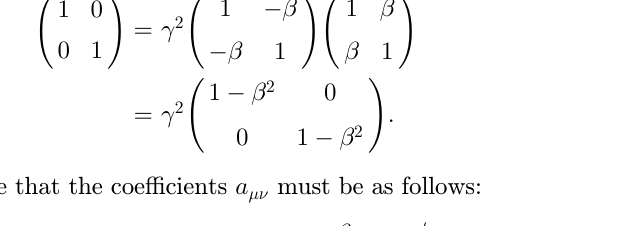
1 ffiffiffiffiffiffiffiffiffiffiffiffiffiffiffiffiffiffiffi